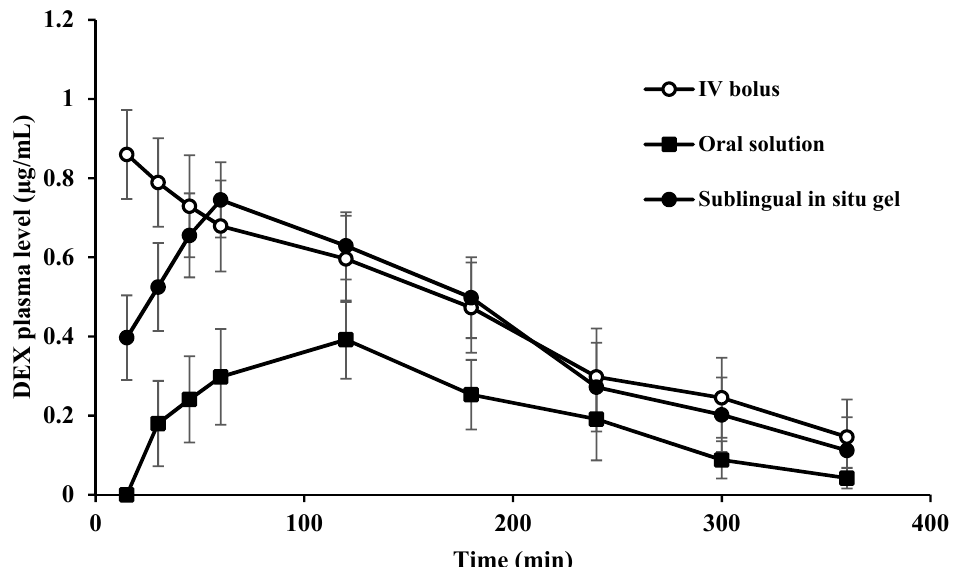
Figure 3. Plasma concentrations of DEX after IV, oral and sublingual administration.